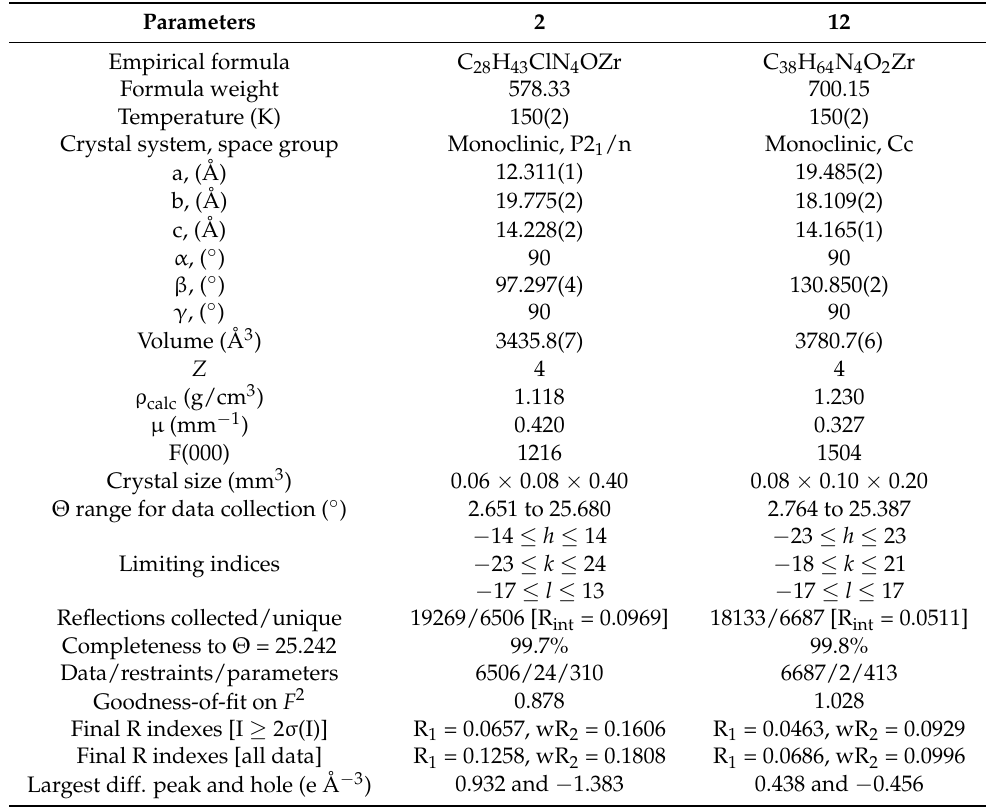
Table 1. Crystal data and details of structure refinement for compounds 2 and 12